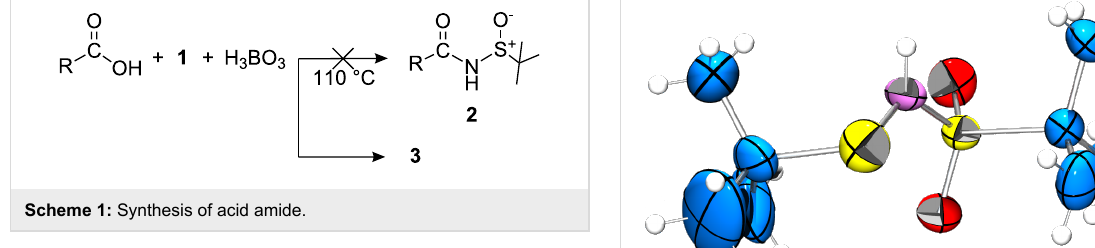
Figure 3: ORTEP diagram of 3 .